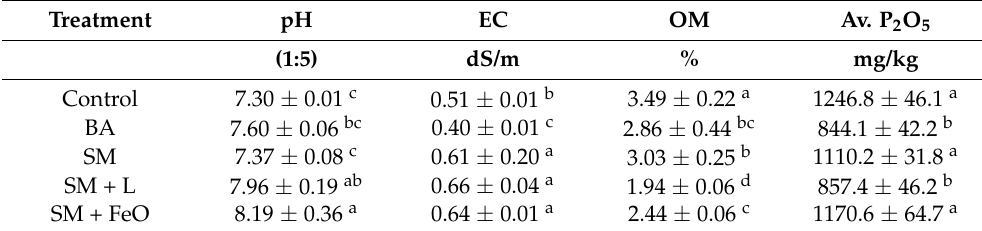
Table 3. Soil chemical properties in the upland field after harvesting the